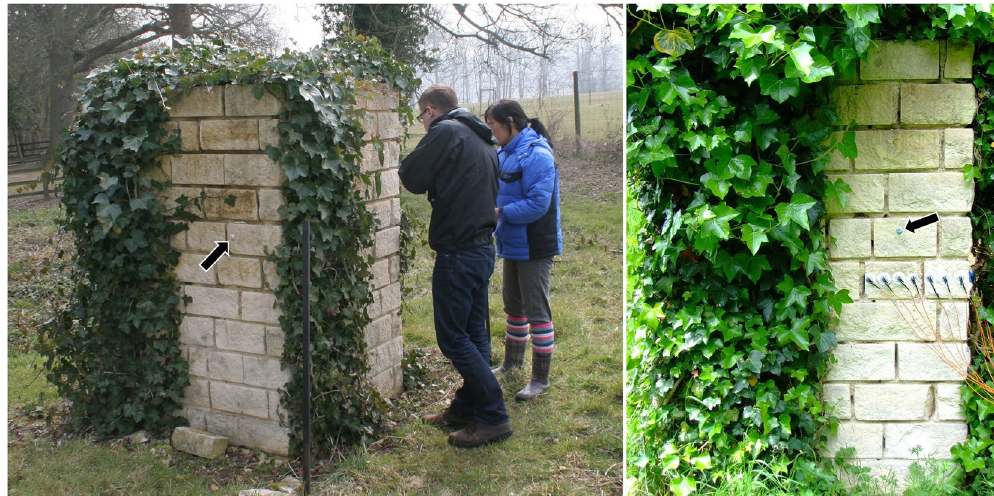
Figure 5. Test walls constructed of Elm Park Limestone and lime mortar, Wytham Woods, Oxfordshire. The structure had four faces (north, east, south and west facing) 1.2 m wide and 2 m high. Ivy was allowed to establish on one half of each face, allowing controlled comparisons between exposed and ivy covered stone. Arrows indicate the position of temperature